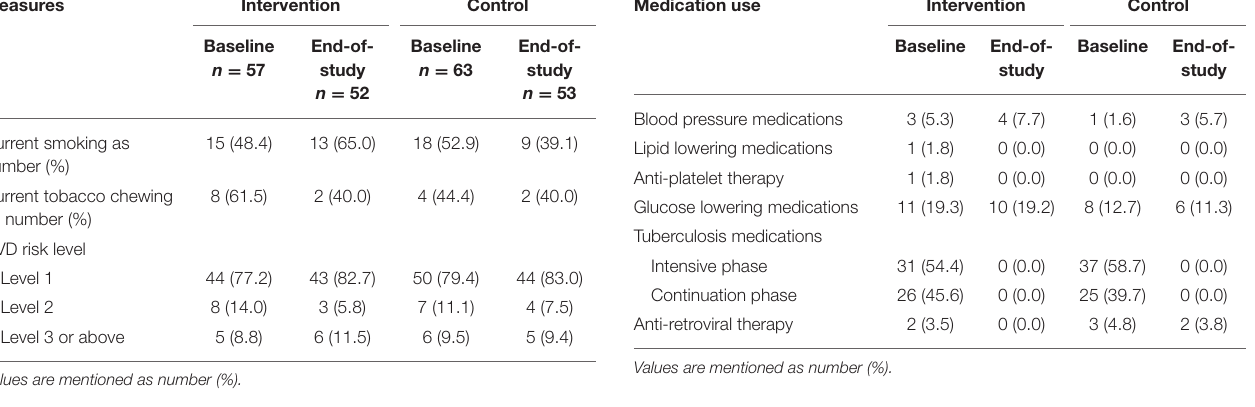
TABLE 3 | Risk factors at baseline and end-of-study. Measures